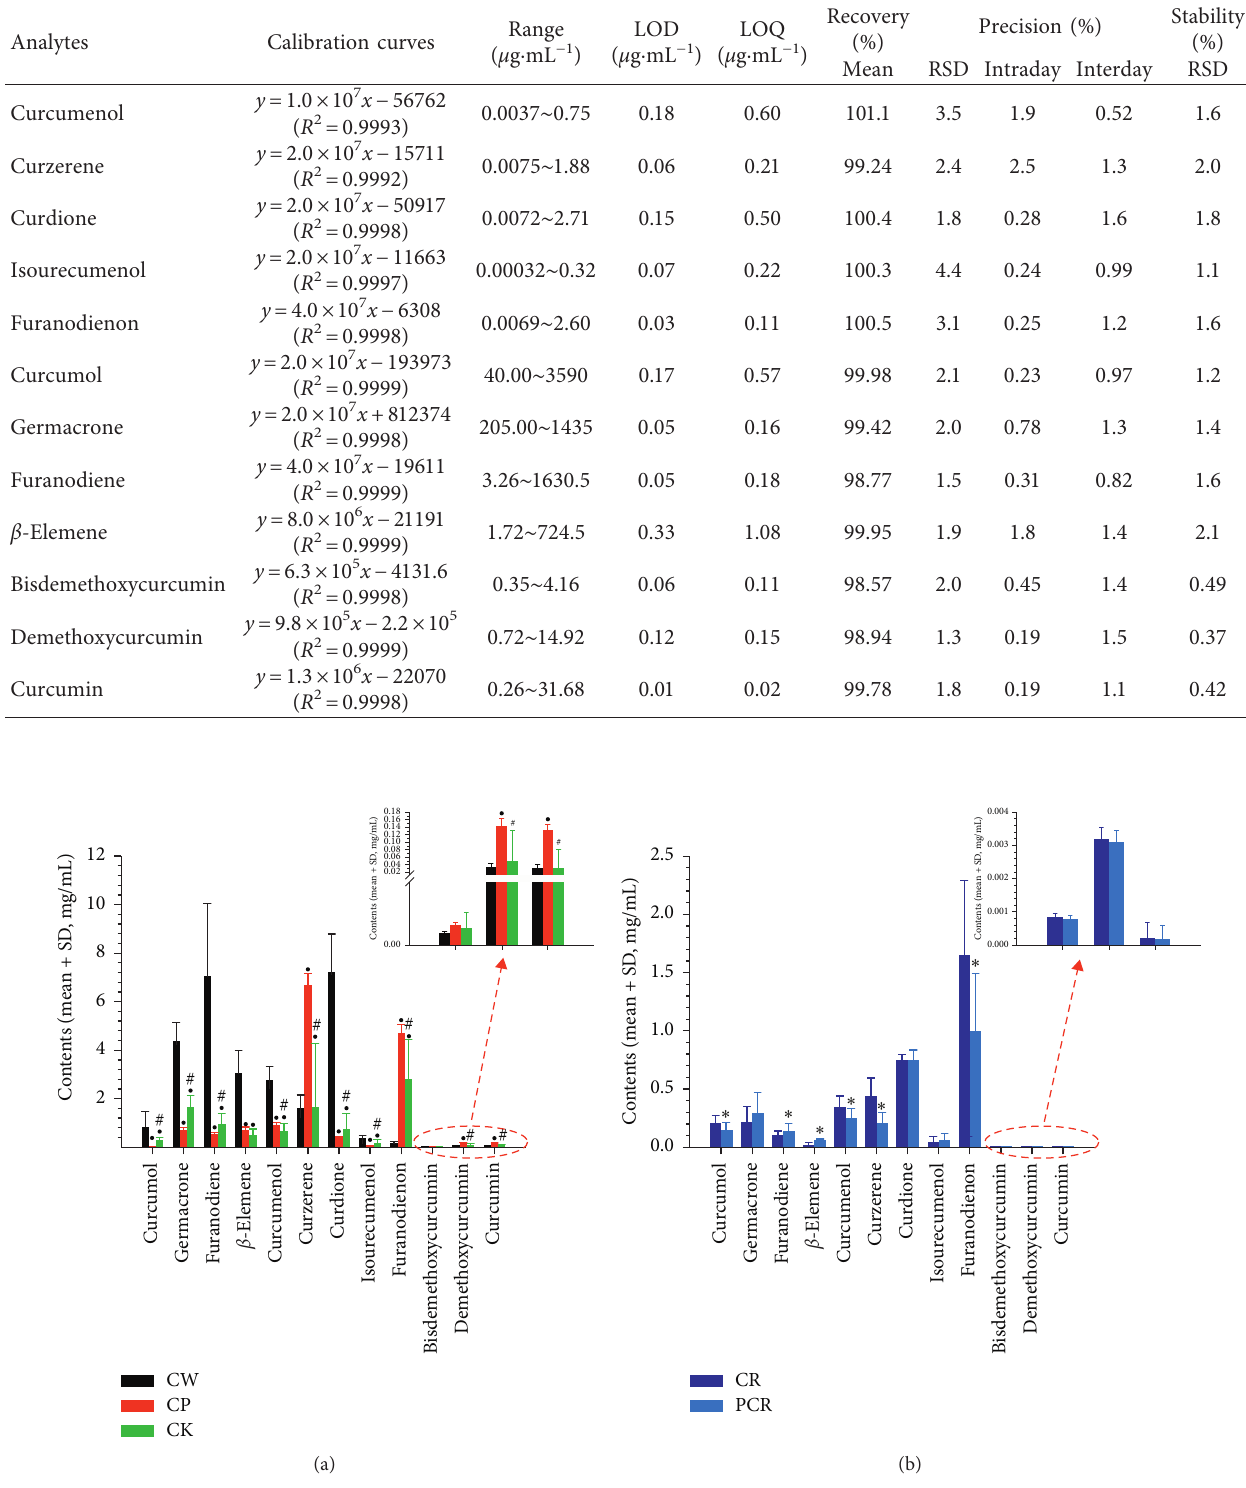
Table 2: The results of methodology validation for HPLC analysis.